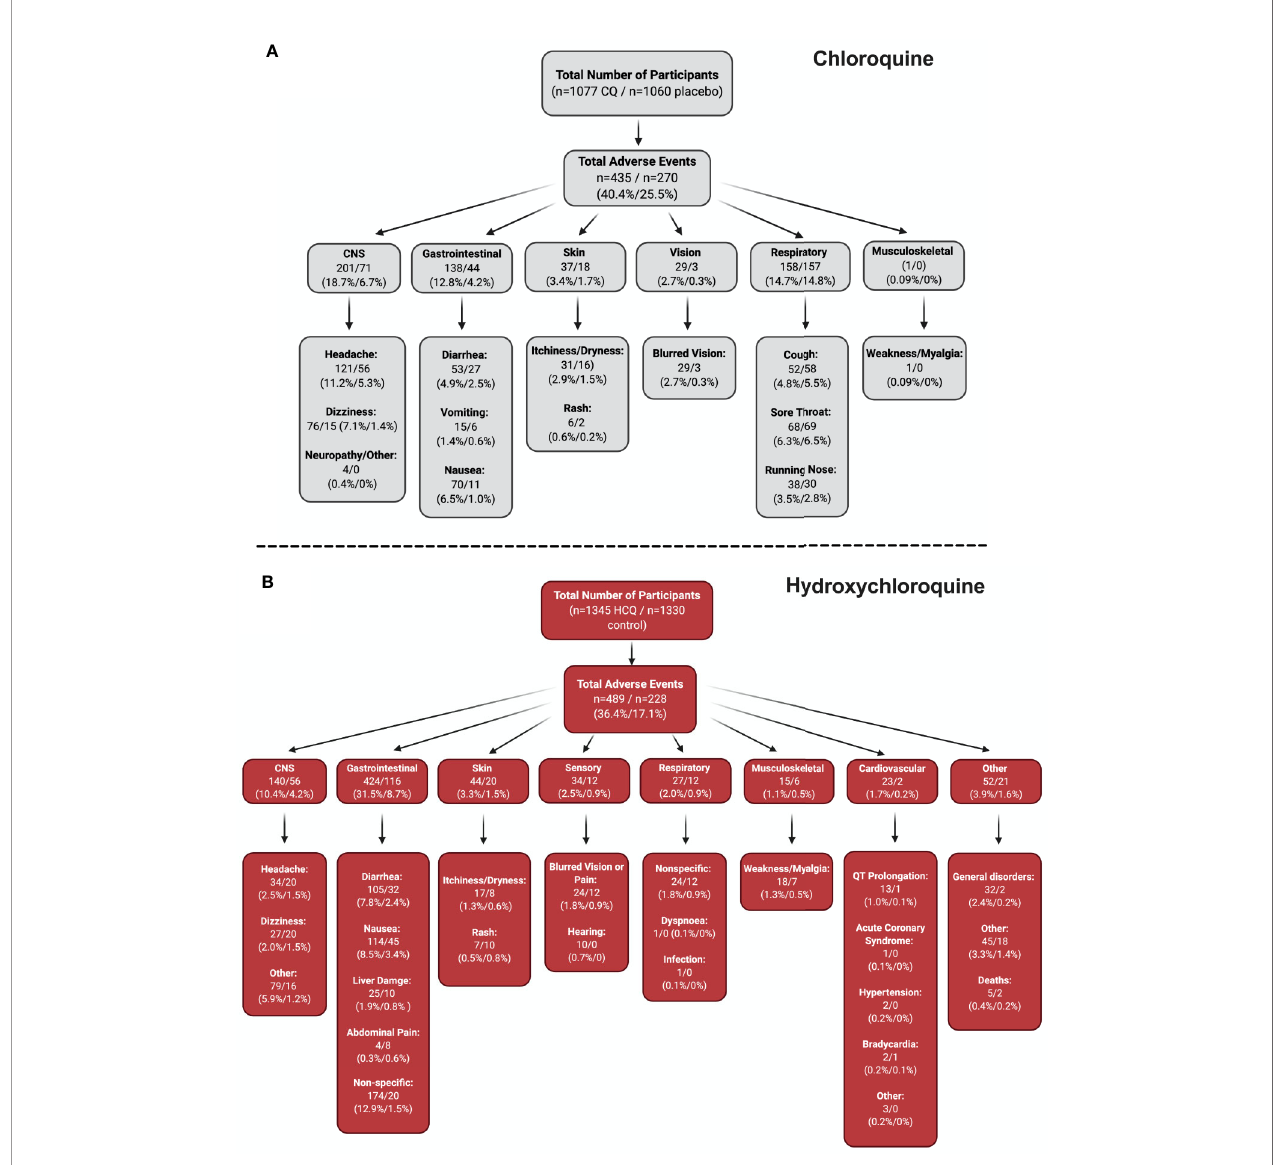
FIGURE 5 | Strati fi cation of all AE. To fully appreciate the wealth of data regarding CQ and HCQ AE, we divided the AE into different categories. Panel (A) depicts the data for CQ, while panel (B) shows the data for HCQ. Both panels begin with the total number of participants in the studies (n = 6 CQ, n = 18 HCQ), which is then followed by the total number of AE. The AE were then divided into different systems, which is then broken down into speci fi c AE. Figure was generated using